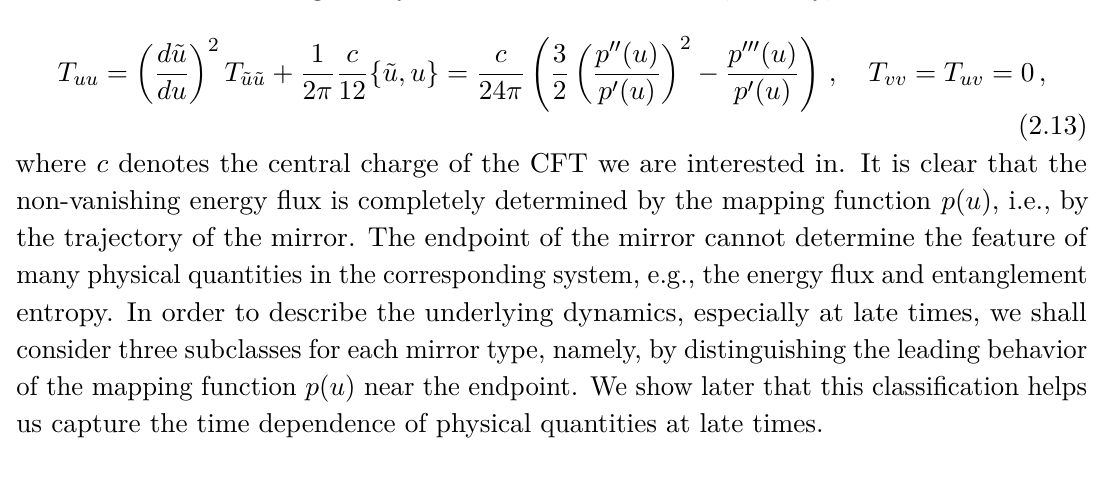
Figure 9 . The corresponding stress tensors associated with conformal mapping functions p ( u ) , p ( u ) , and p ( u ) . The red, black, and blue curves denote the cases with n = 2 , n = 1 , and p B C D , respectively. The dashed purple line represents the position of u = u n = 1 2 chosen c = 24 π